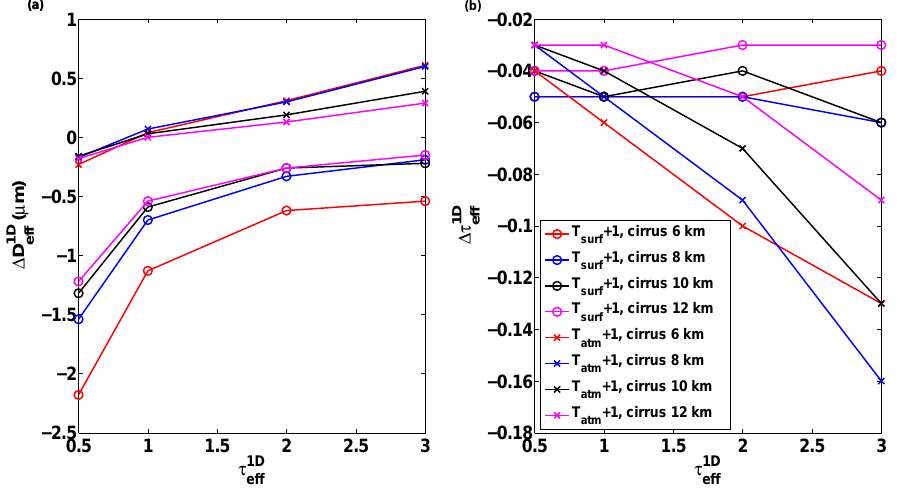
Figure 13. Errors on the (a) retrieved effective diameter, (cid:49)D 1-D due to an error of + 1K on the surface temperature ( T surf + 1) and + 1K on the atmospheric temperature profile ( T atm + 1) for cirrus with top altitudes of 6, 8, 10 and